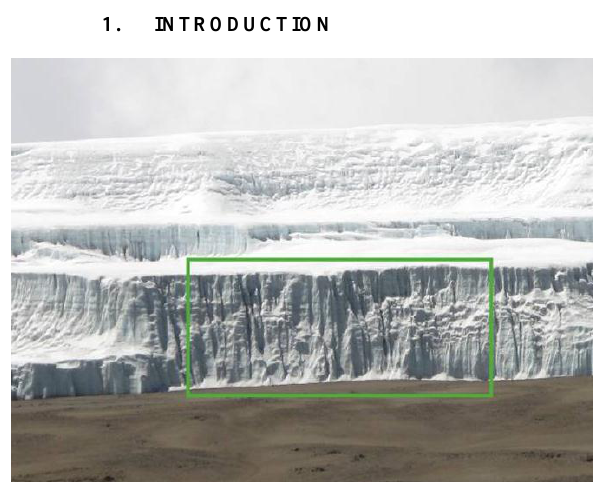
Figure 1: A part of the Northern Ice Field on Kibo. The “sample cliff” is outlined by the green